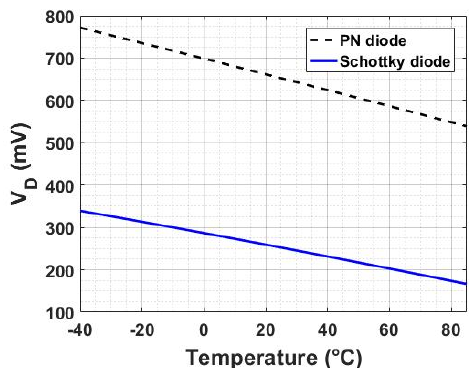
Figure 1. Simulated V D vs. temperature for the Schottky diode and the PN-junction diode.